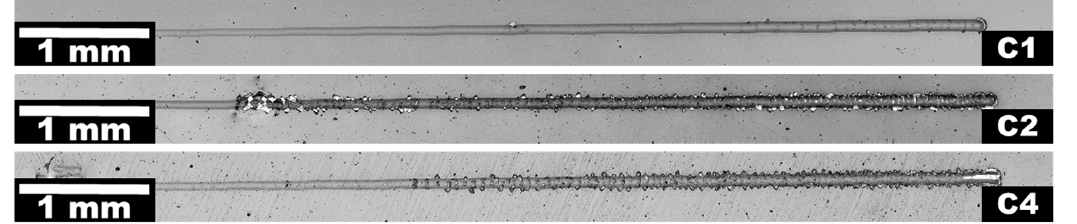
Figure 1. Scratch paths of the M-coatings. In the picture, just final parts of the paths are compared; the paths are incommensurable in this picture.